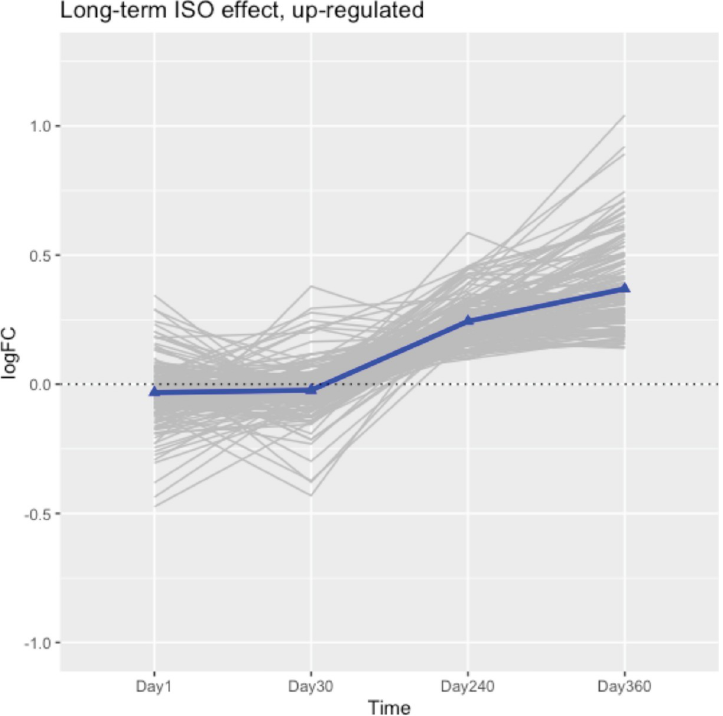
Fig 10. Trajectories of logFC of significantly up-regulated genes that manifest at the late timepoints. The 146 consistently up-regulated genes have FDR adjusted p-values < 0.05 at Day 360 and p < 0.1 at Day 240. Trajectories of individual genes plotted as grey lines. Blue lines connecting blue triangles are the mean trajectory. Groups of rats exposed to air (na ï ve, n = 6/each timepoint group) or ISO (n = 5/Day 1 group, and n = 6/Day 30, 240, and 360 groups) were